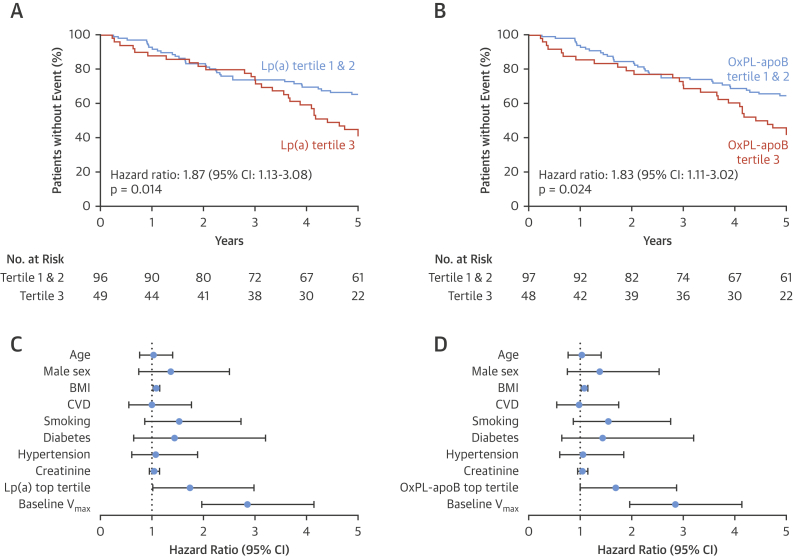
Aortic Valve Replacement or Death During Follow-Up According to Patient’s Lp(a) and OxPL-apoB LevelsKaplan-Meier curves show the composite endpoint of aortic valve replacement surgery and death. Patients in the top Lp(a) and OxPL-apoB tertiles had more events than those in the lower tertiles (A and B). Multivariate Cox proportional hazards analysis for aortic valve replacement surgery and death. Lp(a) and OxPL-apoB emerged as an independent predictor of events alongside the baseline peak aortic jet velocity (C and D). Hazard ratio for age is per 10 years, BMI per kg/m2, creatinine per 10 mg/dl; Vmax per m/s. BMI = body mass index; CI = confidence interval; CVD = cardiovascular disease; Vmax = peak aortic jet velocity; other abbreviations as in Figure 1.